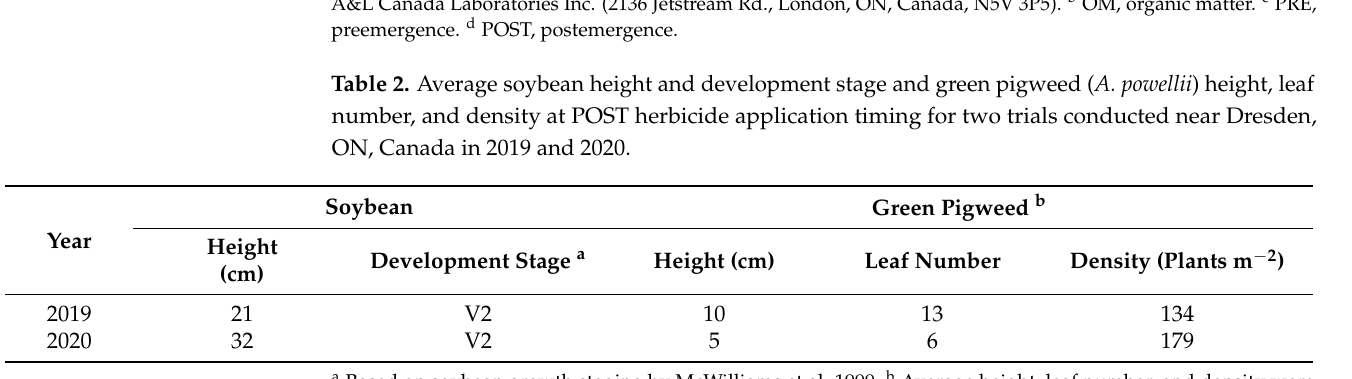
Table 3. Herbicide active ingredients, trade names, and manufacturers for PRE herbicide treatments.